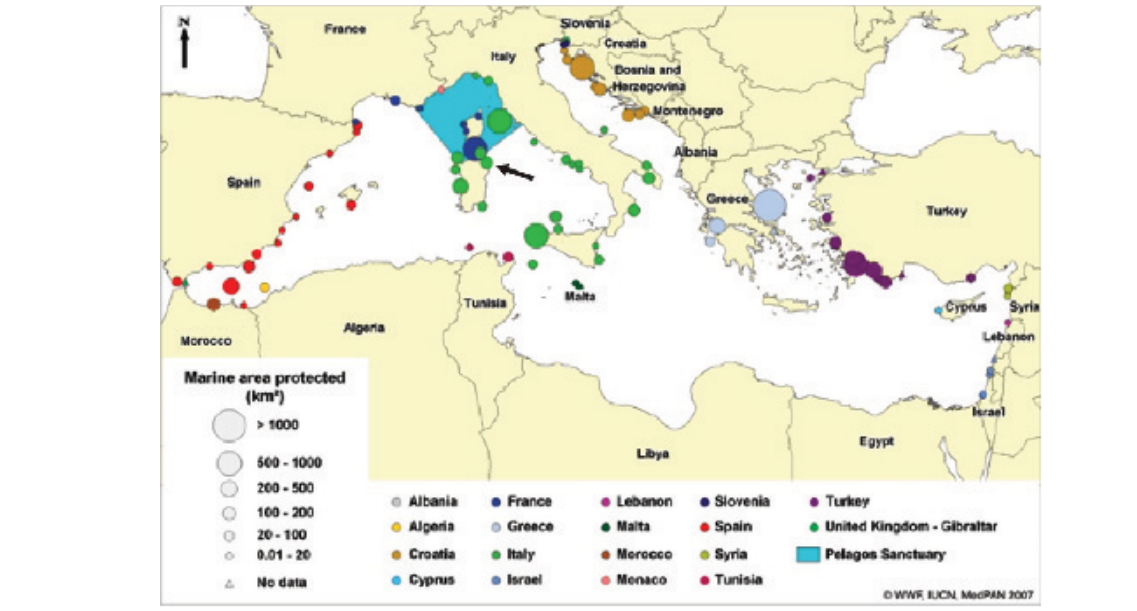
Fig. 2 . Location and size of Mediterranean marine protected areas (from Abdulla et al. 2008, reproduced with permission by the authors). The black arrow marks the location of the Tavolara-Punta Coda